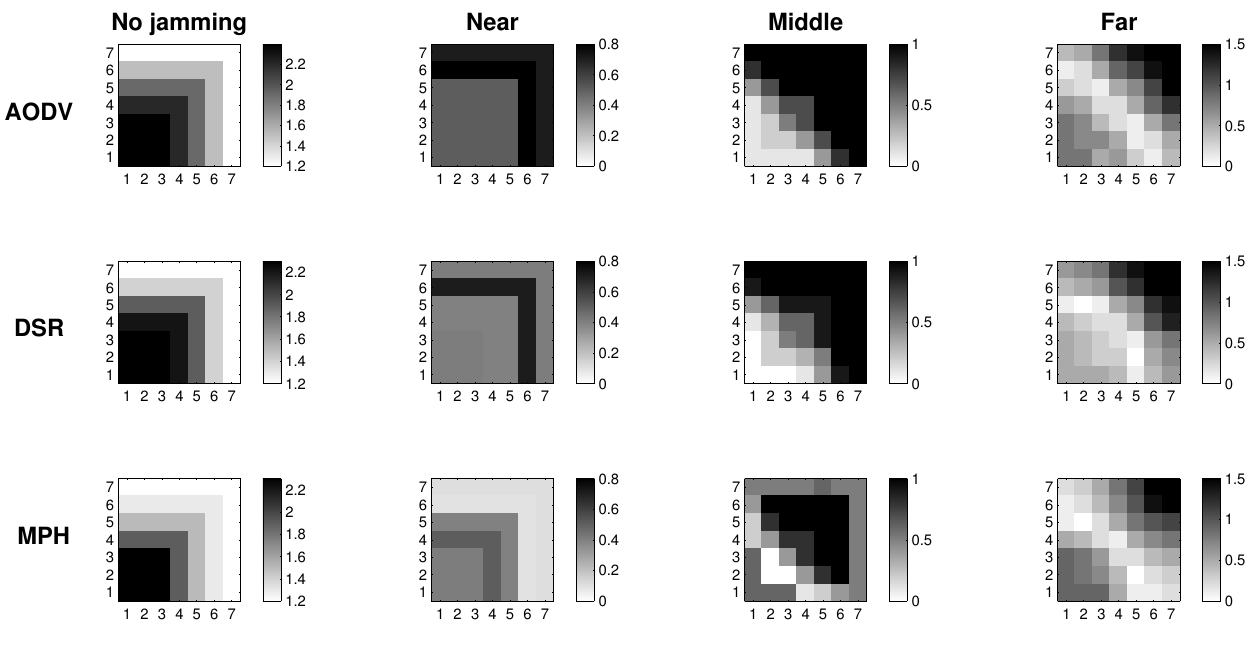
Figure 7. 2D representation of the average retransmissions in the no jamming case and the difference between the values in the reactive and no jamming cases for each of the positions of the jammer